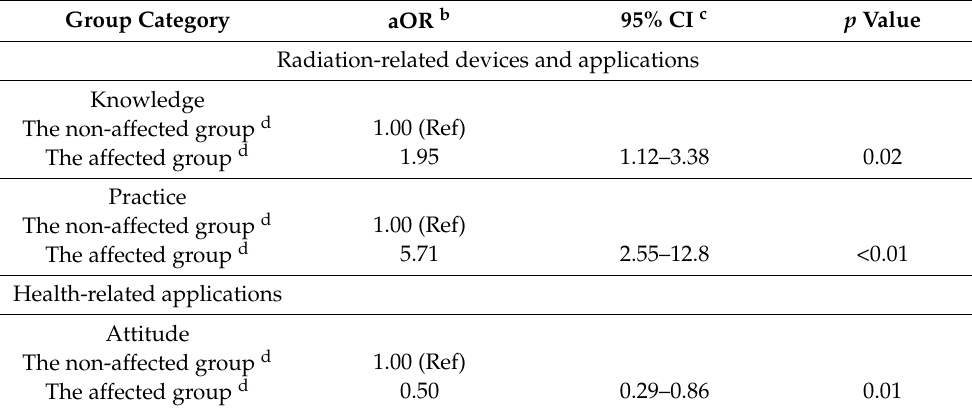
* p -values in parentheses were results of Fisher’s exact test. Table 4. Differences in KAP between two residential groups: multivariate logistic regression analysis a